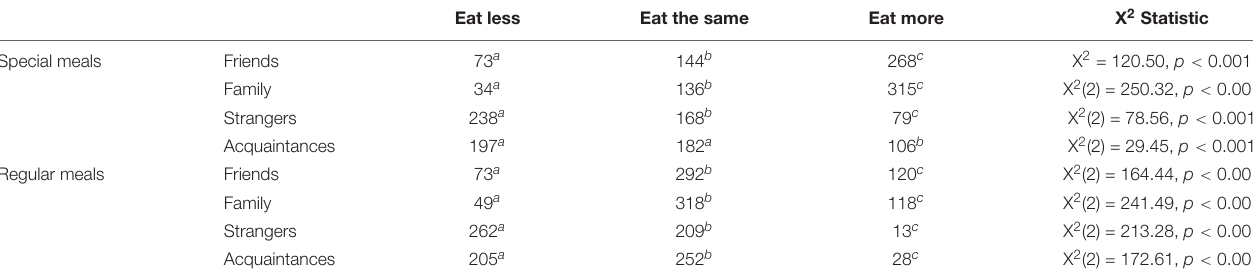
Eat less Eat the same Eat more X 2 Statistic